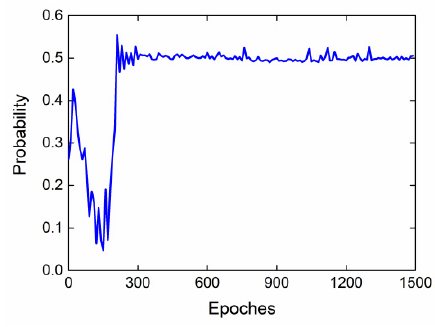
Figure 12. Probability value of the D output.